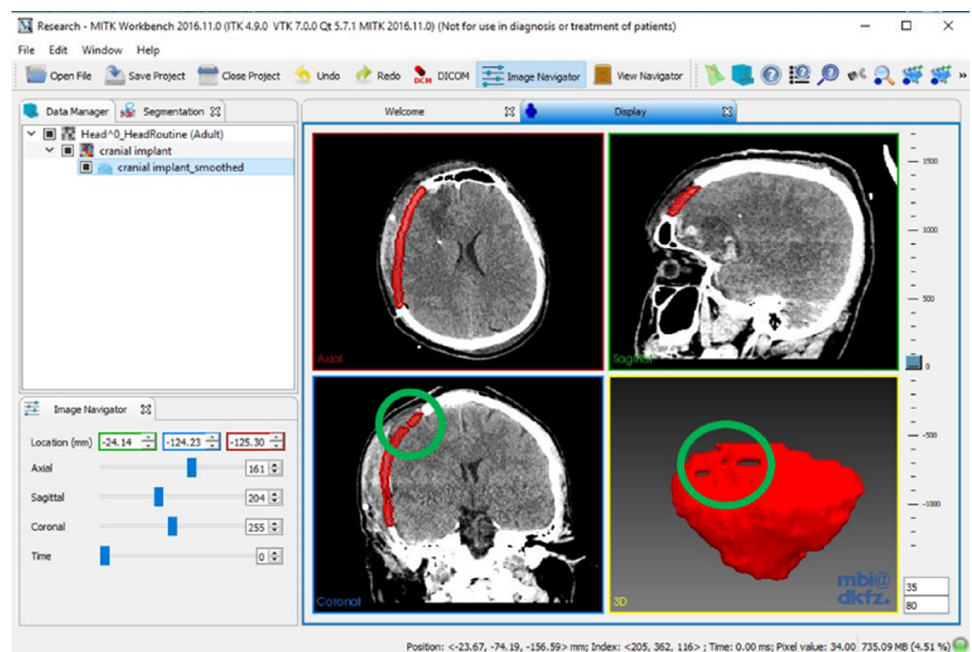
Figure 5. Green circles indicated unreconstructed surfaces due to under-interpolation. As the selected axial slice was performed at every tenth slice, some areas were not interpolated; thus, holes could be seen on the implant. However, it can still be edited on the axial slice to cover the hole or defect of the interpolation, and the redo process can be carried out, as shown in Figure 6.